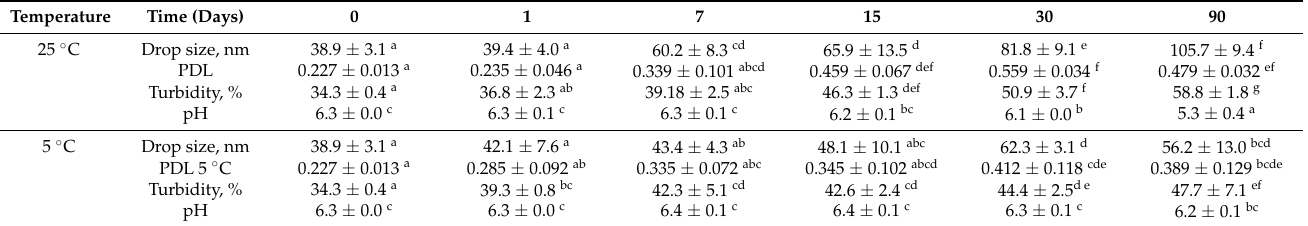
Table 4. Nanoemulsion stability of the Cedrela odorata essential oil at 2.5%. Samples were stored at 25 ± 2 ◦ C and 5 ± 2 ◦ C for 90 days. Two-way MANOVA. Mean values ( ± SE) that do not share the same letter ( a , b , c , d , e , f , g ) are significantly different according to Tukey’s test ( α =